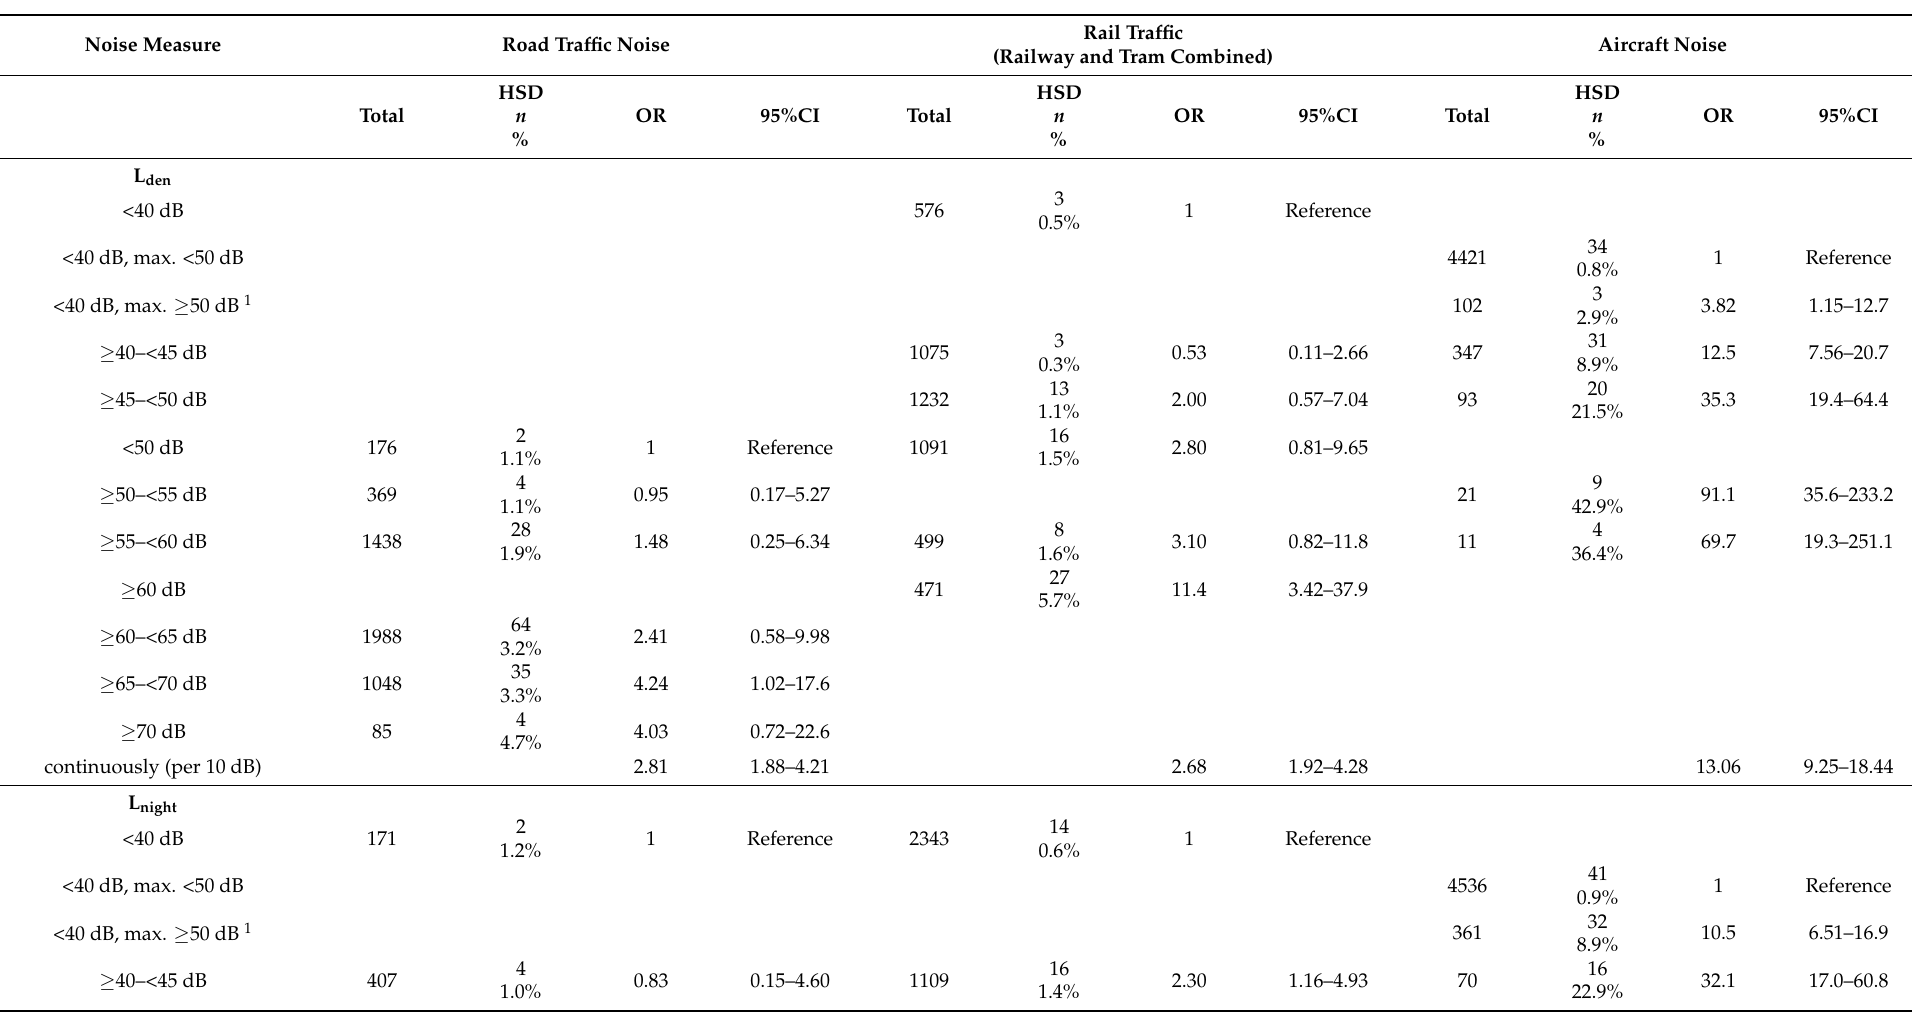
Table 1. Multivariate logistic regression for the risk of HSD from road traffic, rail traffic and aircraft